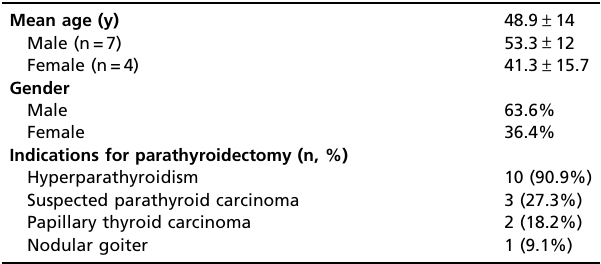
Table 1 - Demographic features and indications for surgery of parathyroid carcinoma patients.